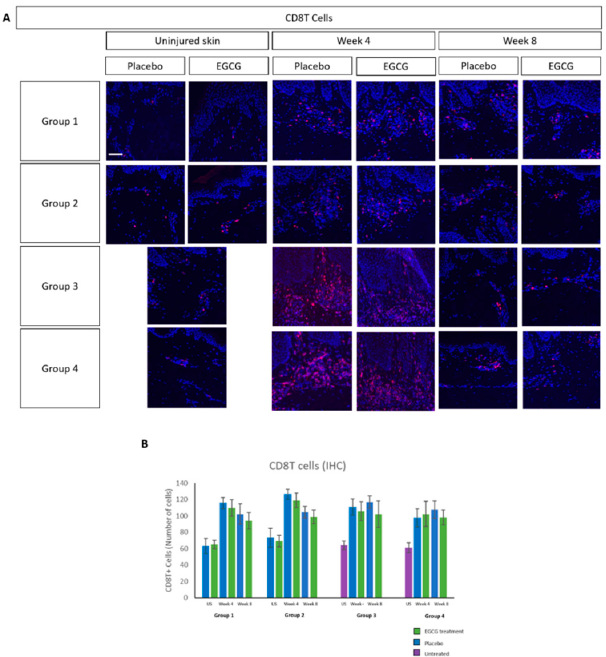
Figure 11. Immune cell analysis of total number of CD8T cells in whole tissue. ( A ) CD8T cell marker analysis showed that levels were higher than uninjured skin in all groups and in placebo and treated samples. ( B ) CD8T cell levels were similar at week 4 and at week 8 and no significant differences were noted between treated and placebo or between groups. Scale bars = 50 μ m.